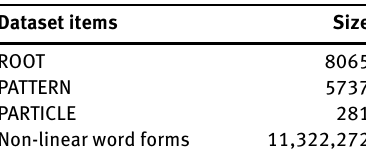
Figure 2: Process of Construction of an Abstract Morpho-Phonetic Query Vector Based on Associative Cognitive Variables Relationships and Their Instantiation. Table 1: Considered Root